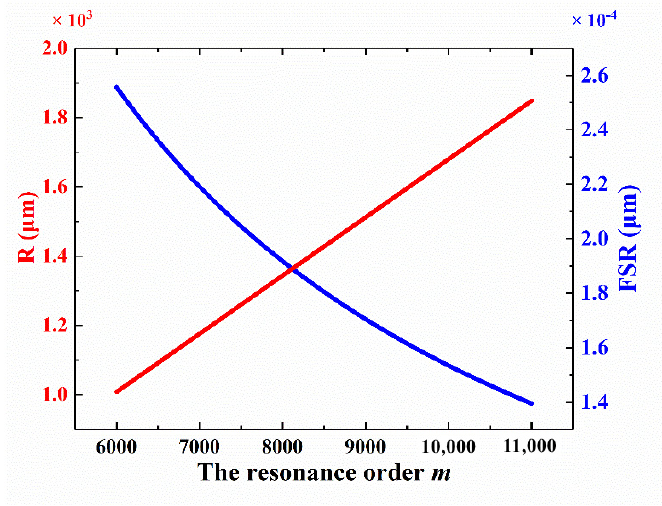
Figure 4. Relations between the resonance order m and the ring radius R and the free spectral range (FSR).